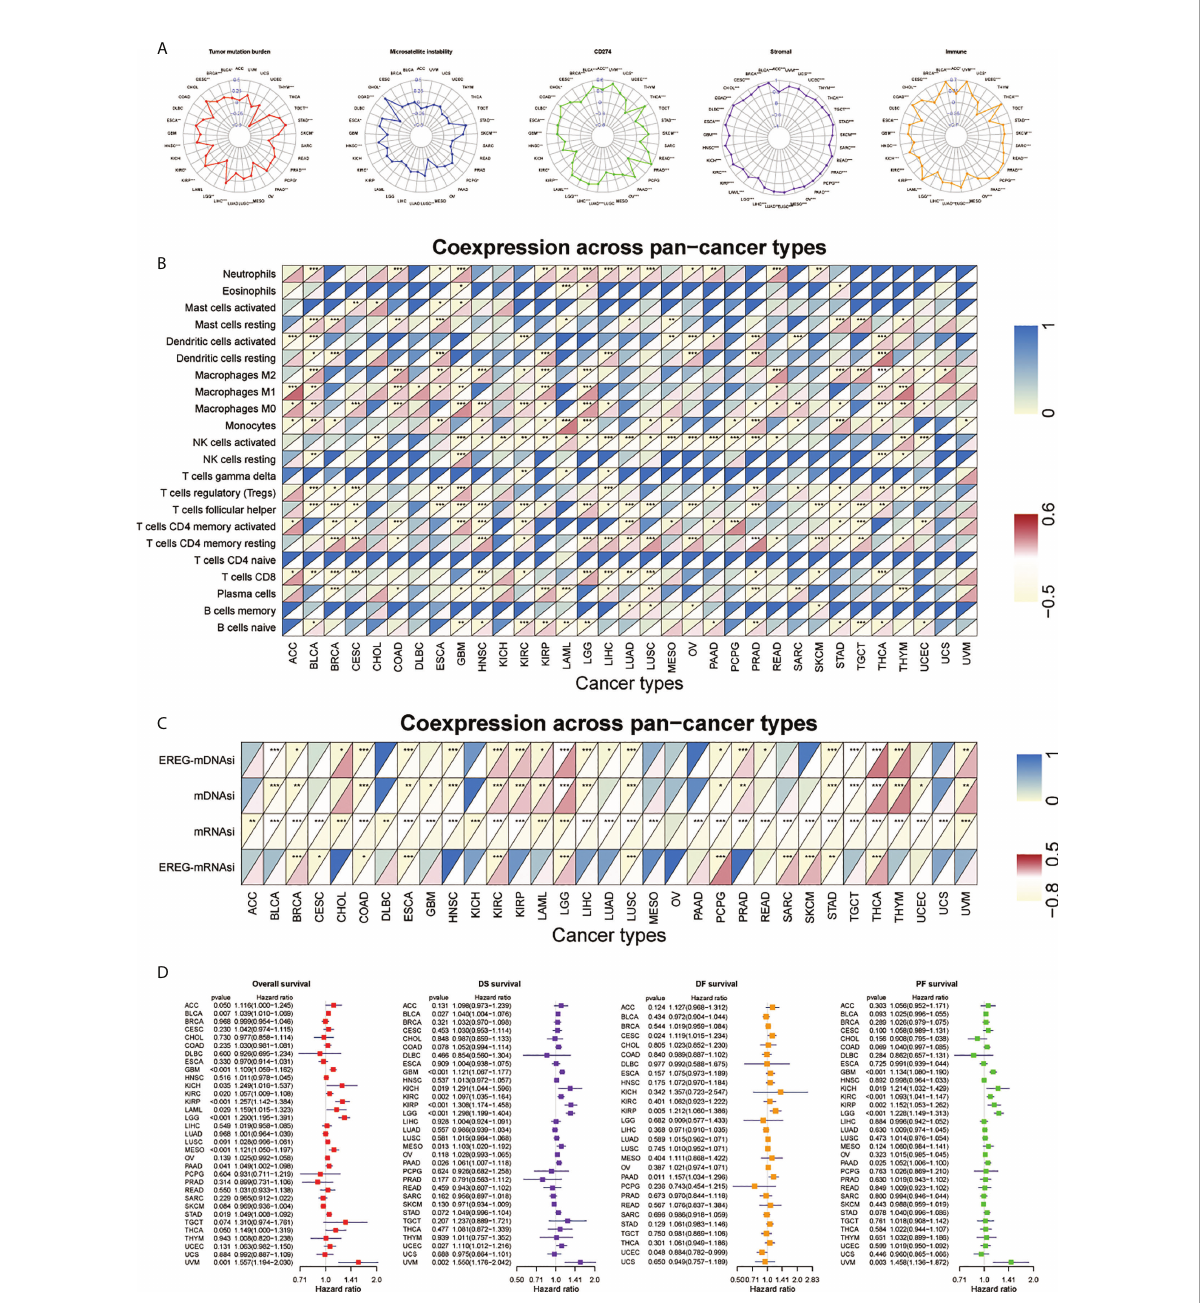
FIGURE 7 Performance of SNHGscore among pan-cancer. (A) Radar plot of the correlation between SNHGscore and TMB, MSI, CD274 expression, stromal score as well as immune score. (B) Relationship between SNHGscore and immune cell in fi ltration levels in pan-cancer. (C) Correlation between the SNHGscore and stemness indices among pan-cancer. (D) OS, DSS, DFS, and PFS analyses for the SNHGscore in pan-cancer calculated by univariate Cox regression algorithm. All data are presented as the means ± SD, ns, P>0.05, *P<0.05, **P<0.01,